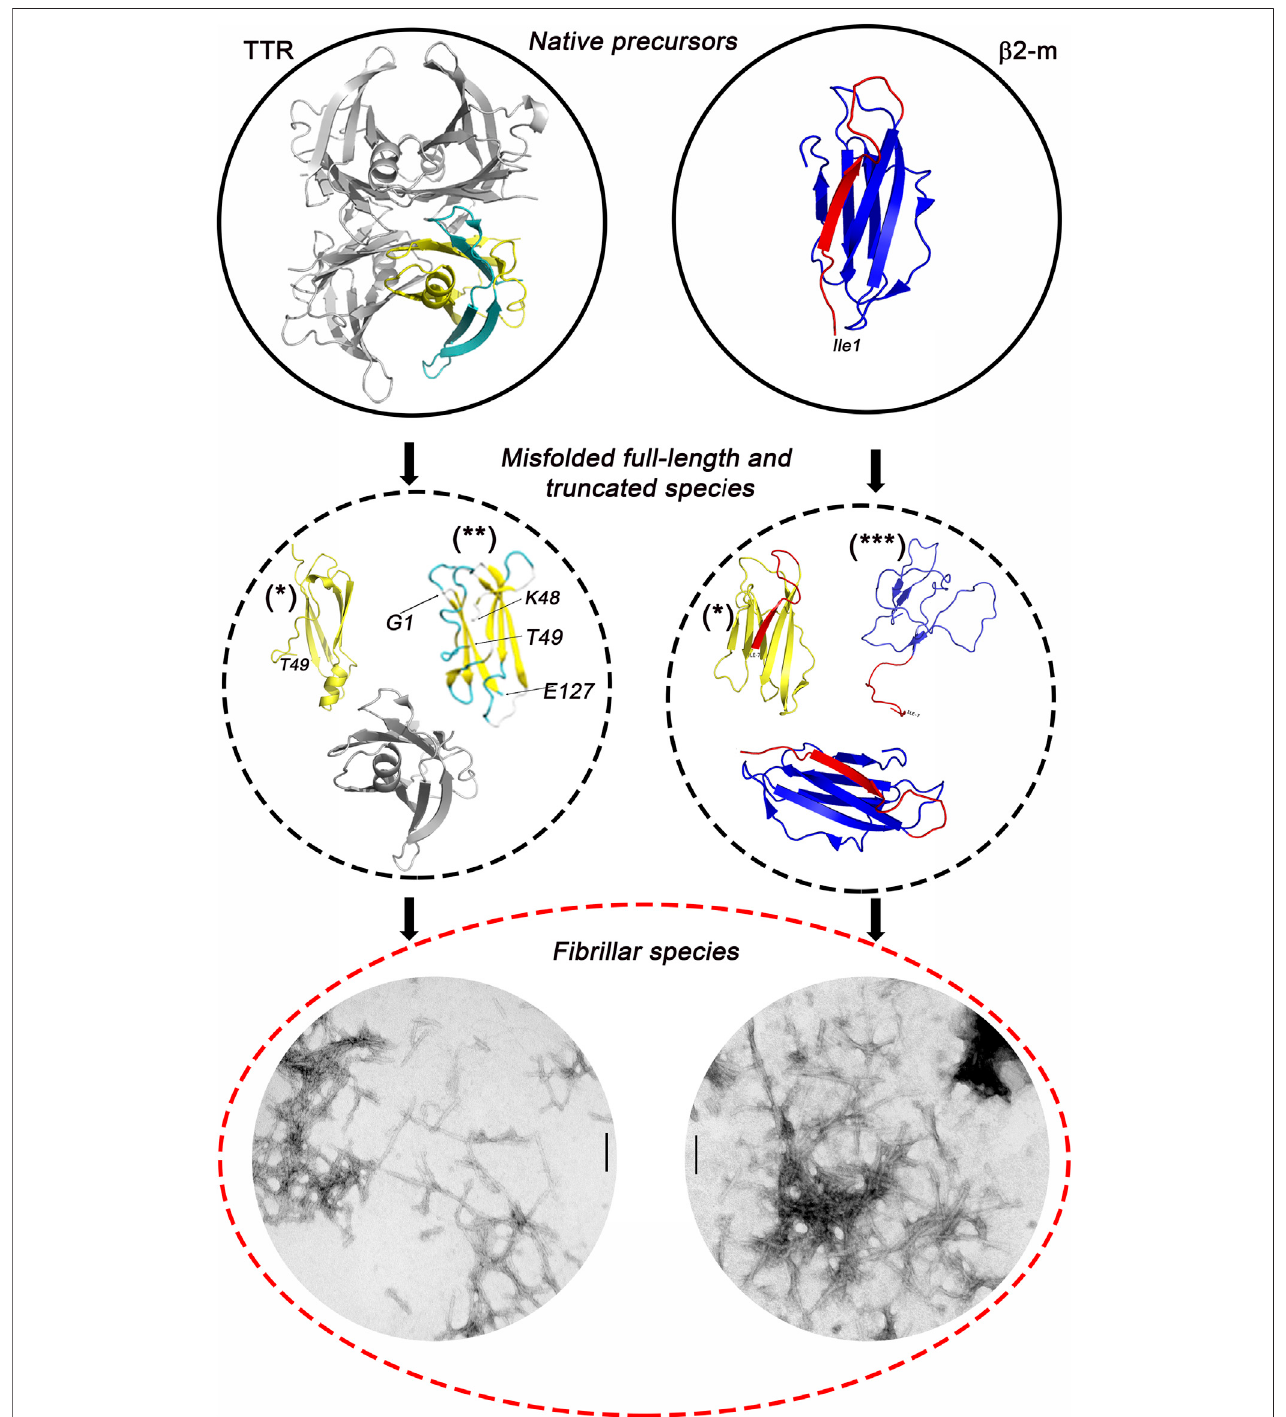
FIGURE 9 | TTR and β 2m amyloid formation pathway. Both native proteins may undergo selective proteolytic cleavage generating misfolded amyloidogenic intermediates whose structures still remain elusive even applying advanced structure prediction software such as AlphaFold2. However, despite their different native structure, when misfolded, both TTR and β 2-m convert into fi brillar structures that are morphologically similar as shown by negatively stained transmission electron microscopy (scale bar = 100 nm). (*) = structures predicted using the AlphaFold2 software; (**) = conformations predicted using molecular dynamics simulation (Marcoux et al., 2015); (***) = structures derived from NMR spectroscopy measurements (Esposito et al., 2000).